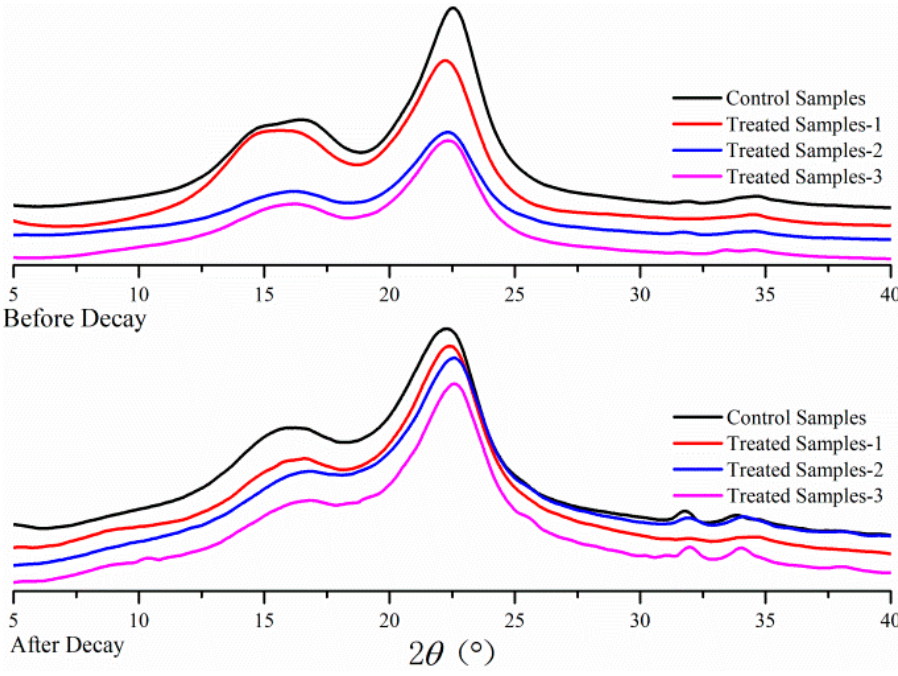
Figure 5. X-ray di ff raction (XRD) patterns of wood samples before / after decay. Figure 5. X-ray diffraction (XRD) patterns of wood samples before/after decay. Table 3. Crystallinities of wood samples before / after